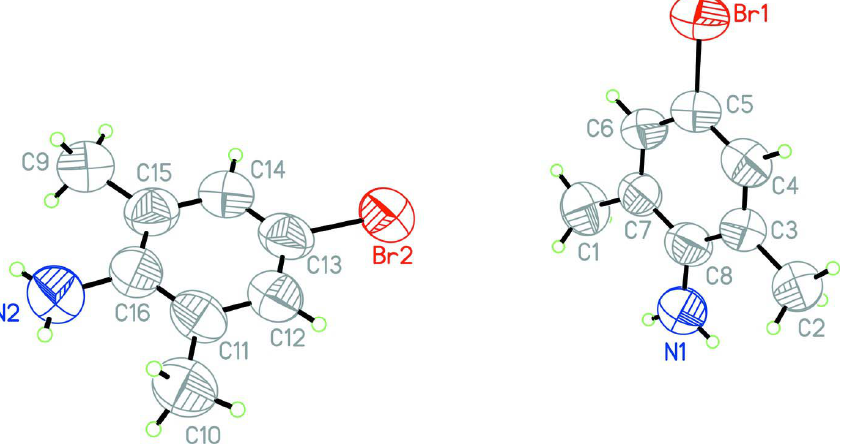
The molecular structure of the title molecule with the atom-numbering scheme. Displacement ellipsoids are drawn at the 50% probability level. Hydrogen bonds are shown as dashed